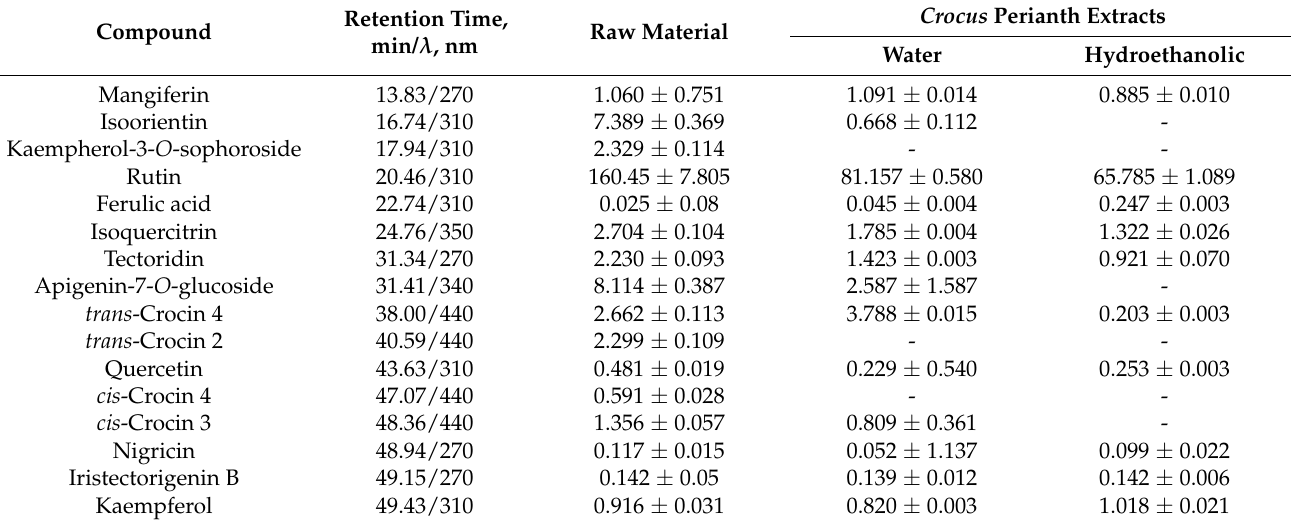
Table 4. Compound content (mg/g) in C. sativus perianth and its crude